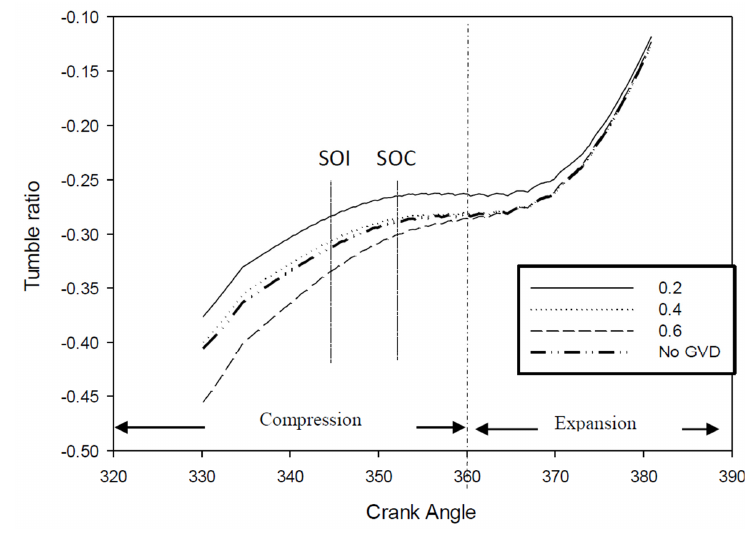
Figure 10. Tumble ratio (R T ) against the crank angle ( θ ).